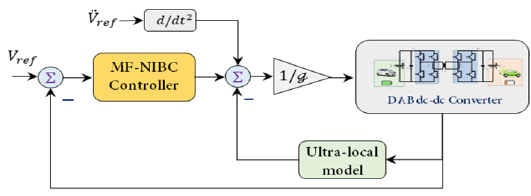
Figure 4. Structure of NIB-MFC loop